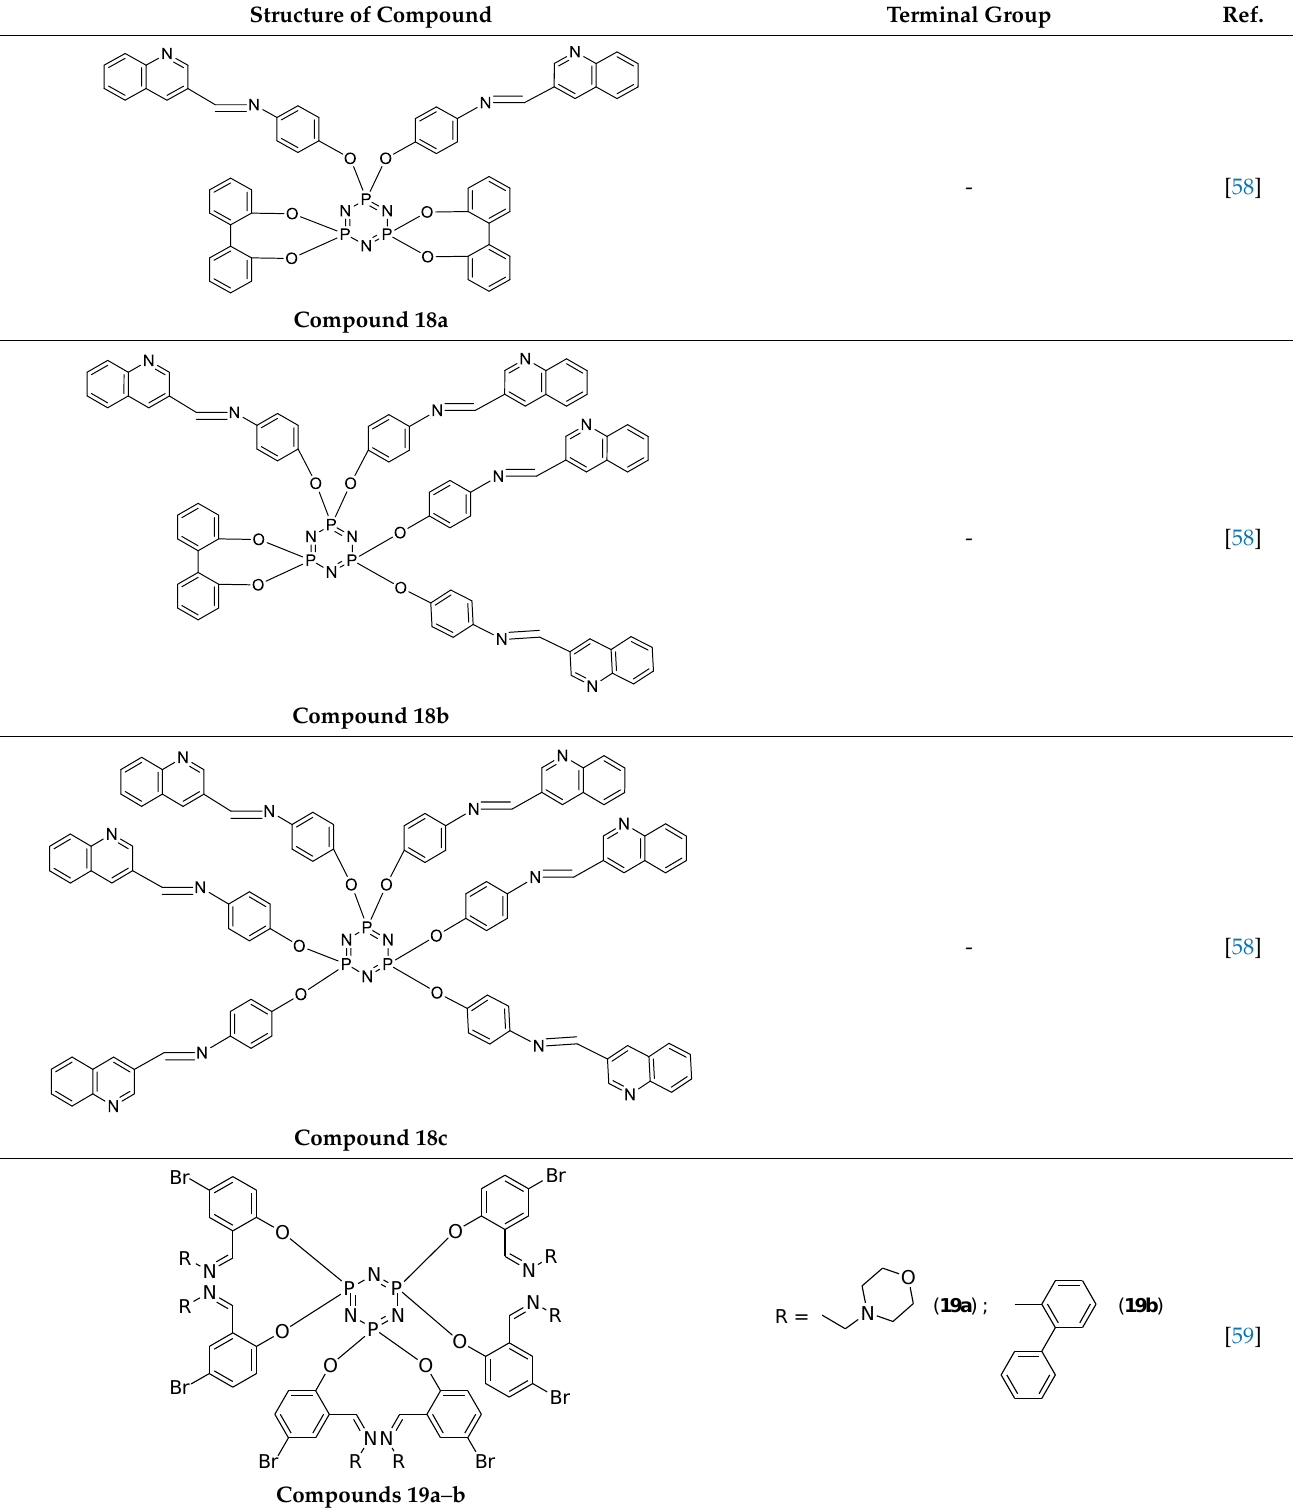
Table 6. Cont. Structure of